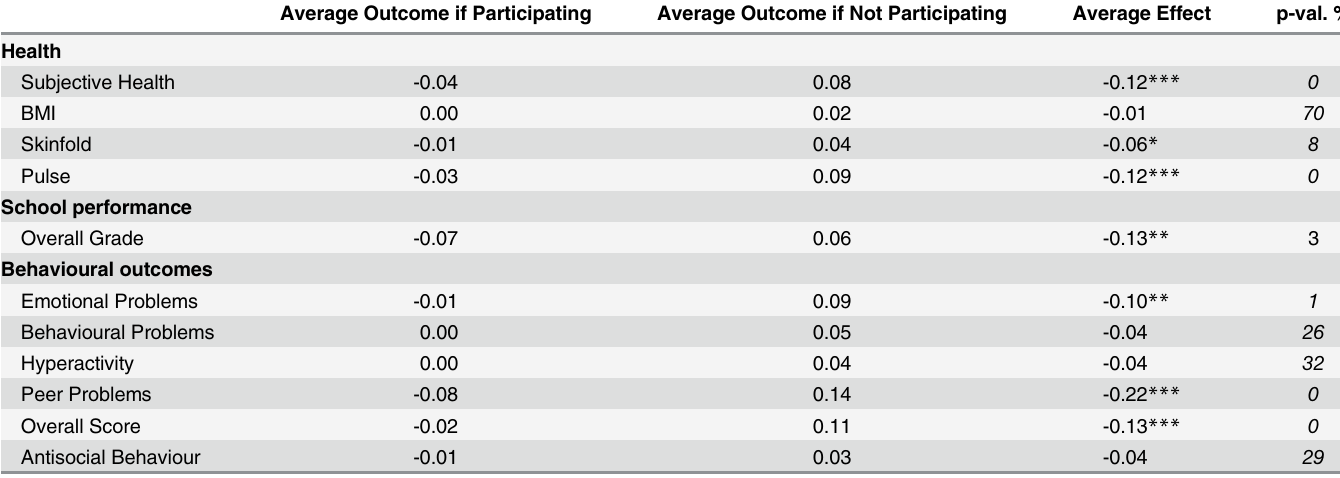
Table 4. Matching estimates for health, school performance and behavioural outcomes (KiGGS). Note: Effect presented is the average treatment effect (ATE). p-values are computed by bootstrapping p-values of the t-statistic with 4999 replications. Note that all variables are standardized to mean zero and variance